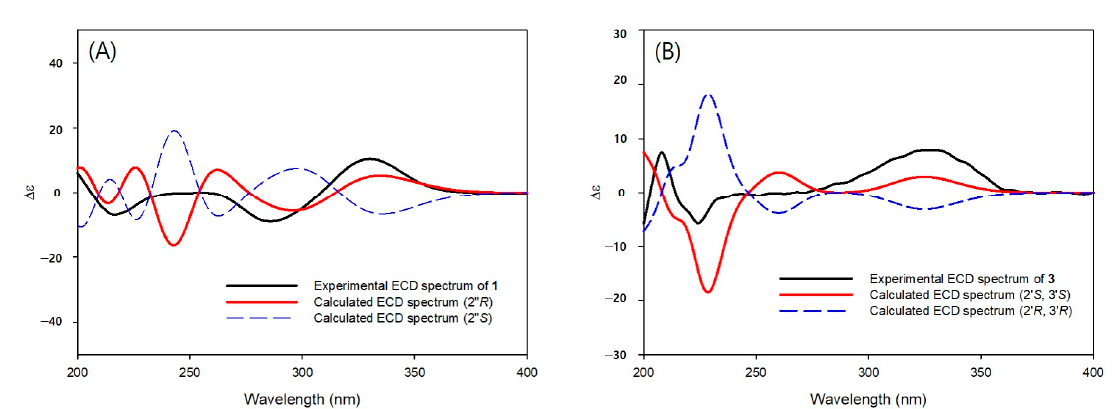
Figure 3. Experimental and calculated ECD spectra of compounds 1 ( A ) and 3 ( B